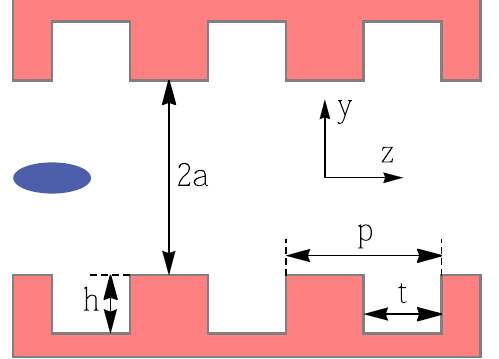
FIG. 1. Geometry of a dechirper unit. For a round dechirper the radius of the aperture is designated as a ; in the flat case, for a vertical dechirper unit, 2 a represents the gap, and the structure is unbounded in x . The blue ellipse represents an electron beam propagating along the z axis.